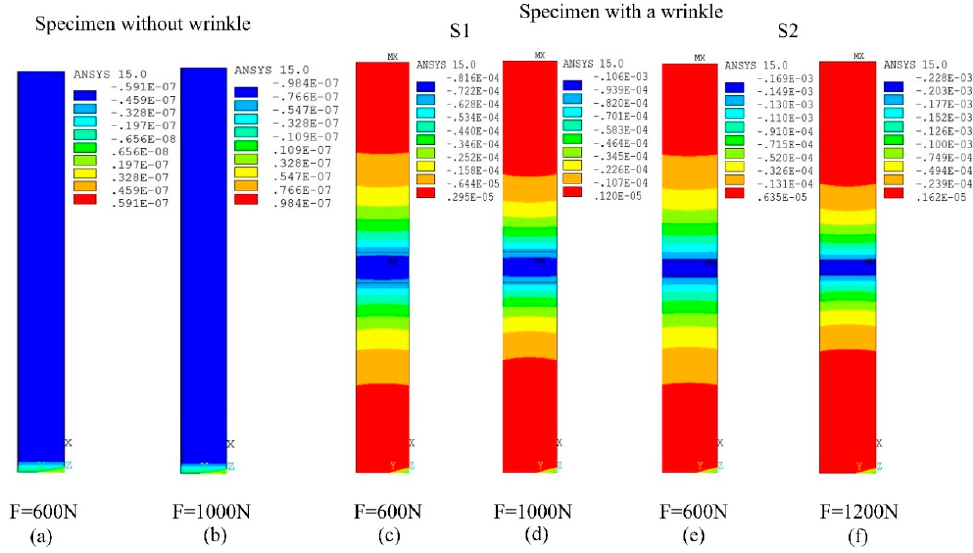
Figure 11. FEA simulation for specimens with/without wrinkle defects.